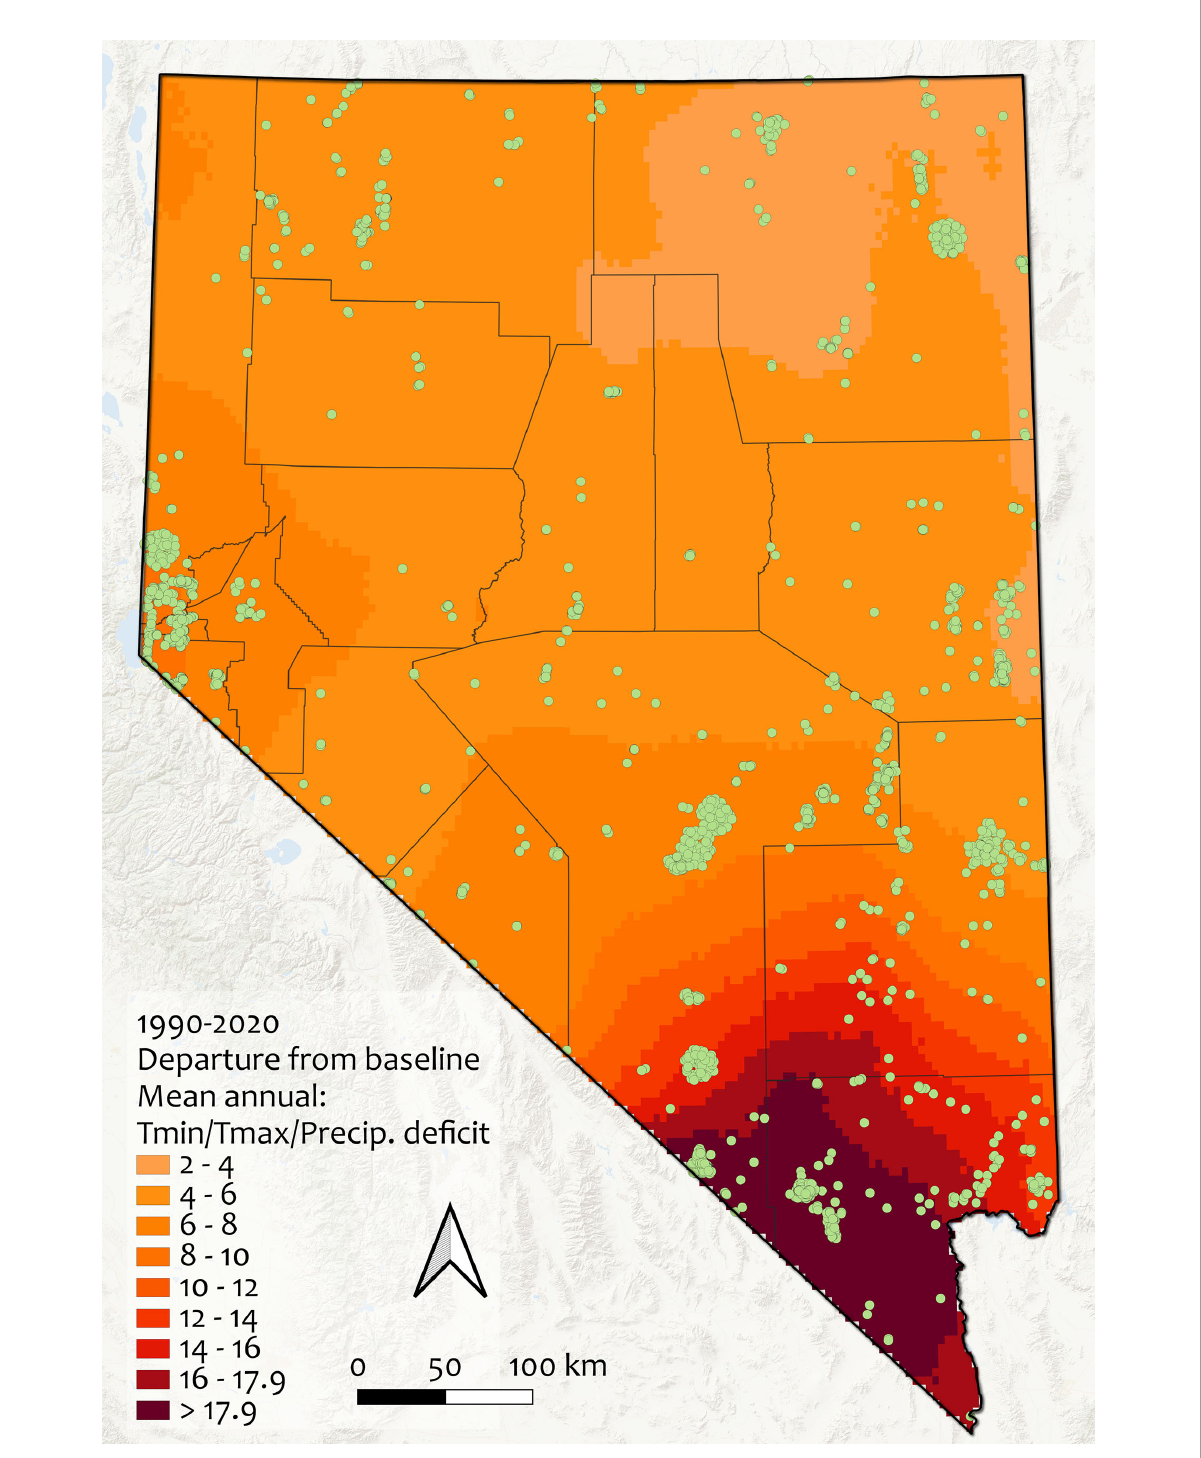
FIGURE 5 Climate change exposure across Nevada between 1990-2020, as departure from baseline (1960-1989). Units are in standard deviations of mean Mahalanobis distance, a multivariate metric calculated from mean annual minimum and maximum temperatures and precipitation. Values >2 are considered non-analogous climate and values >4 are extreme differences; note that no areas of the state have values less than 2 and that all rare plant occurrences experienced notable climatic changes (range: 3.53-20.40). Green points indicate rare plant occurrences, gray lines show county